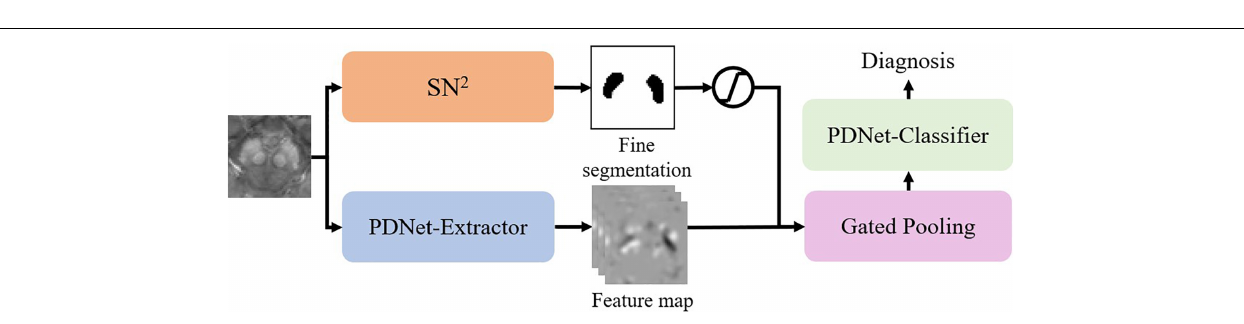
FIGURE 5 | Unified deep learning framework for the automatic diagnosis of Parkinson’s disease.